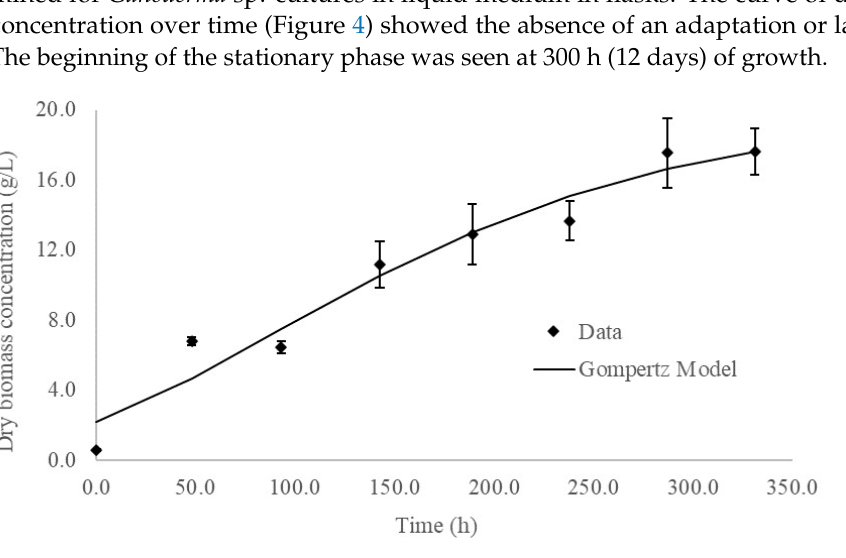
Figure 5. Dry biomass concentration (at 12 days) and k L a (before inoculation) for the two airflow rates tested at the stirred tank bioreactor. Error bars indicate the standard deviation of two inde- pendent replicates. The effect of the airflow rate on the growth of Ganoderma sp. in stirred tank bioreac- tors has been previously studied. Tang, Y. et al. (2003) [17] obtained a maximum concen- tration of 15.62 g dry biomass/L after eight days of culture with a k L a of 78.2 h − 1 (0.5 vvm,